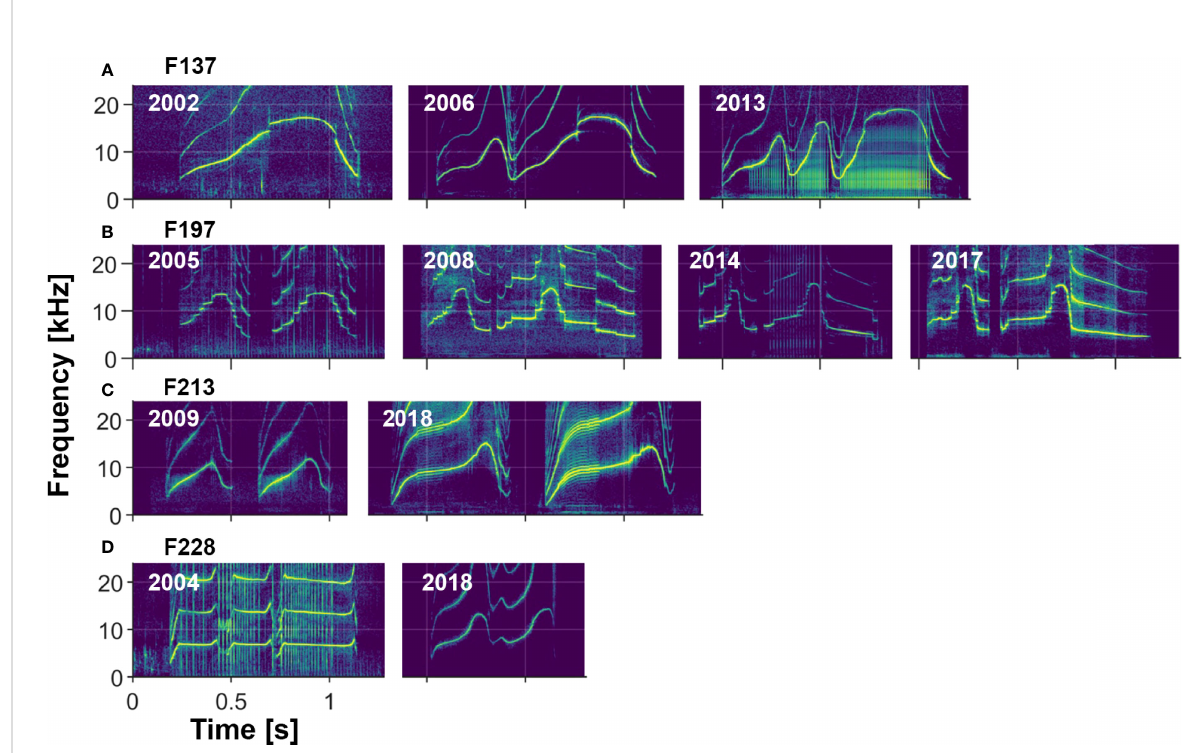
FIGURE 9 Four examples of changes to signature whistles over time. (A) F137 changed her whistle from a single-loop to a multi-loop form sometime between 2002 and 2006. Two loop versions still occurred in 2013 but the three loop version was more common. (B) F197 changed her whistle between 2005 and 2008, after which it remained fairly stable. (C) F213 changed her whistle between 2009 and 2018, increasing the frequency range and modulation of the contour. Sidebands indicative of amplitude modulation are evident in her 2018 whistle. (D) F228 made a drastic change to his whistle contour between 2004 (when he was with his mother) and 2018 (when he was with a male alliance